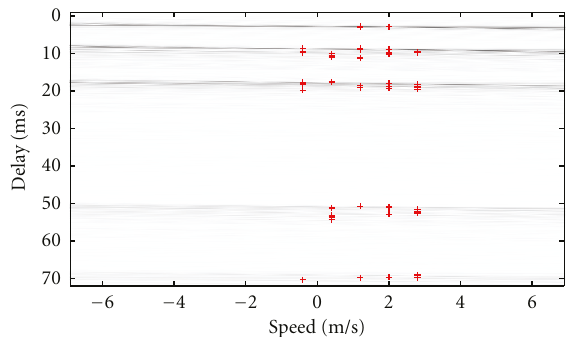
Figure 7: Wideband ambiguity function of the received LFM signal in the KAM08 experimental data. The crosses represent the maxima detected after each MPD iteration.